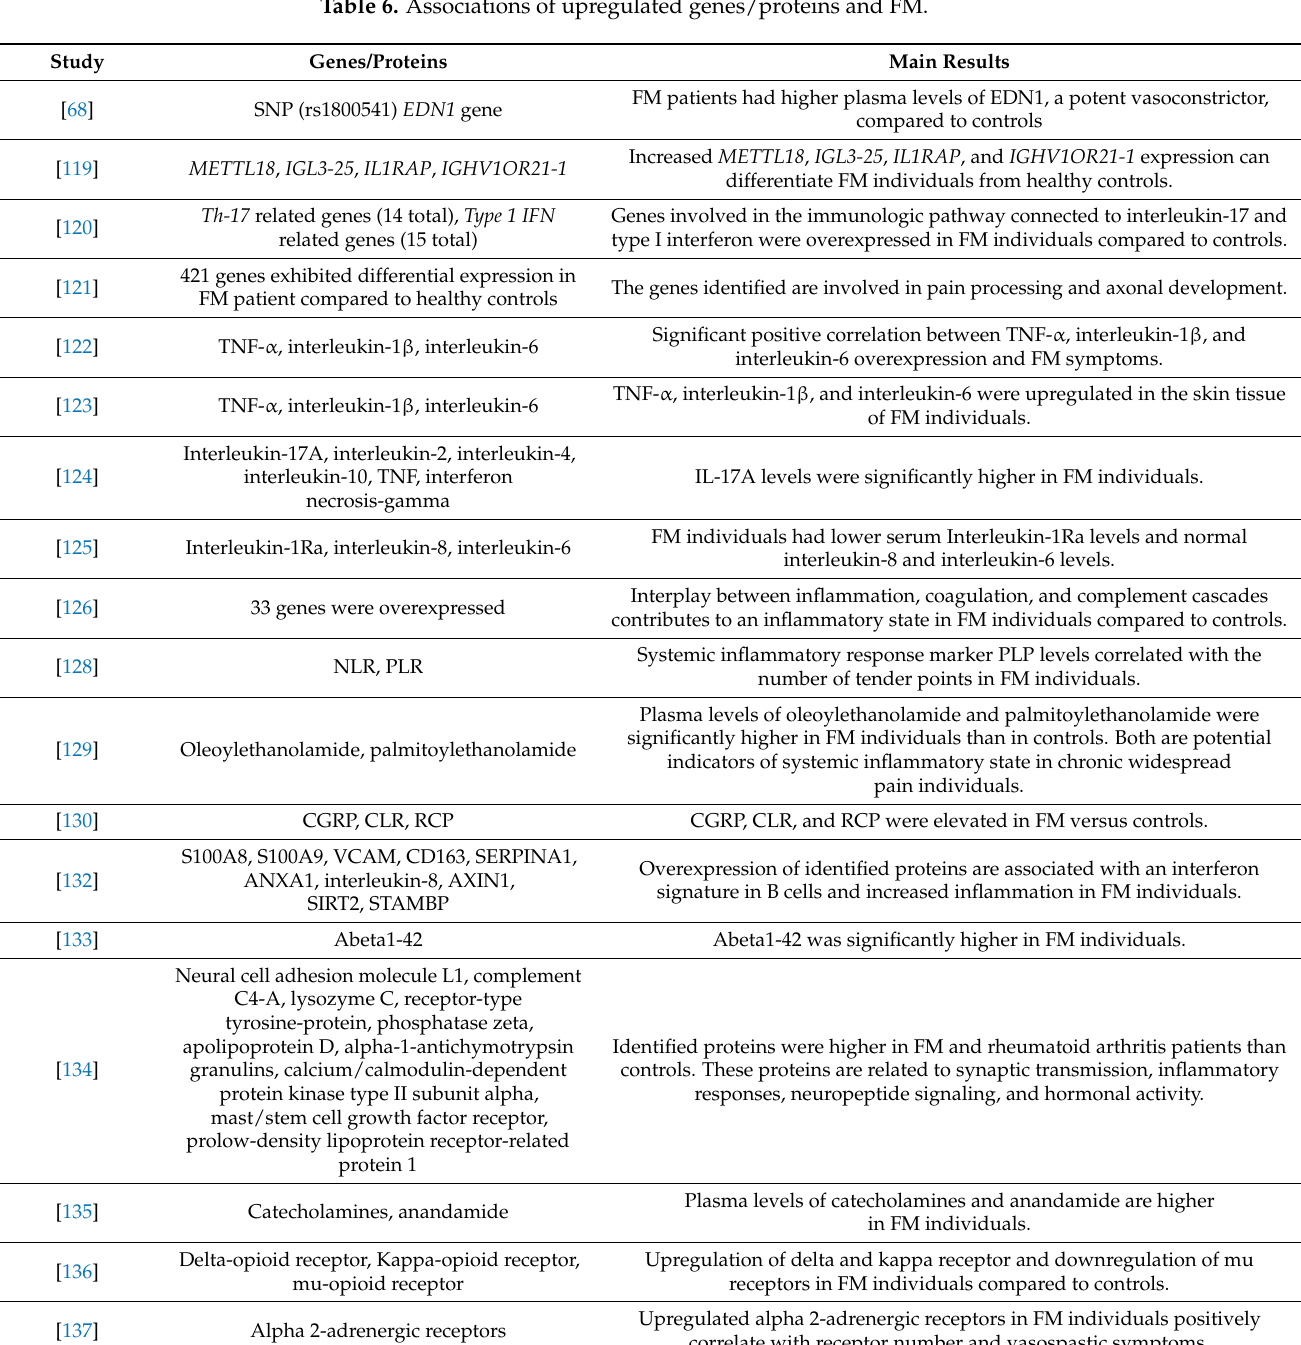
Table 6. Associations of upregulated genes/proteins and